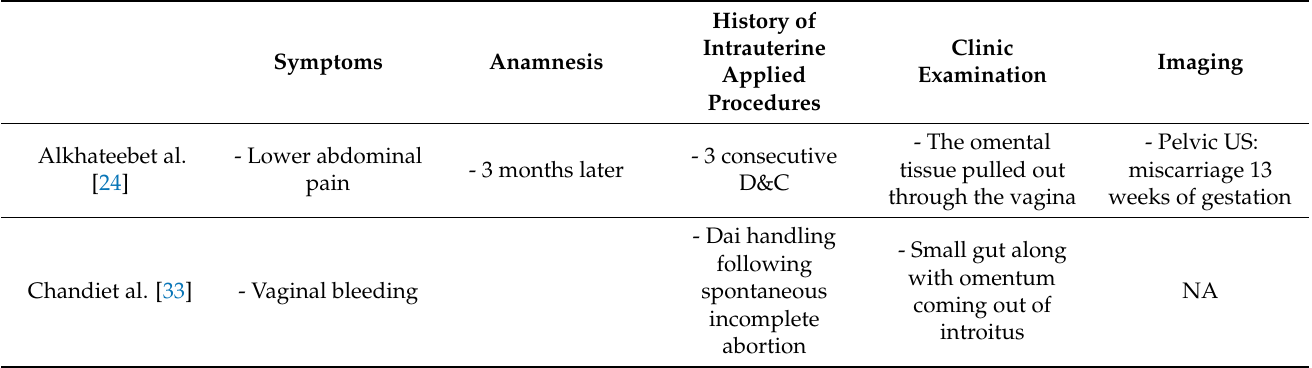
Table 2. Clinical data, anamnesis, imaging results (CT-computer tomography, MRI-magnetic reso- nance imaging,